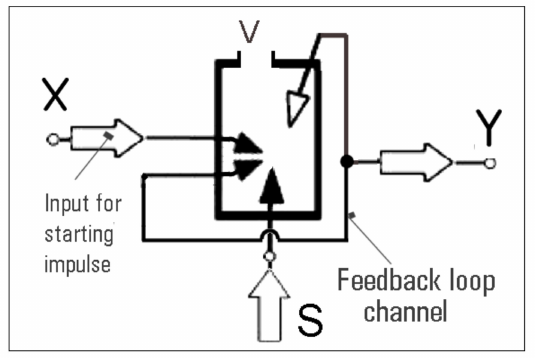
Figure 9. Positive feedback loop channel added to the simple amplifier from Figure 4.